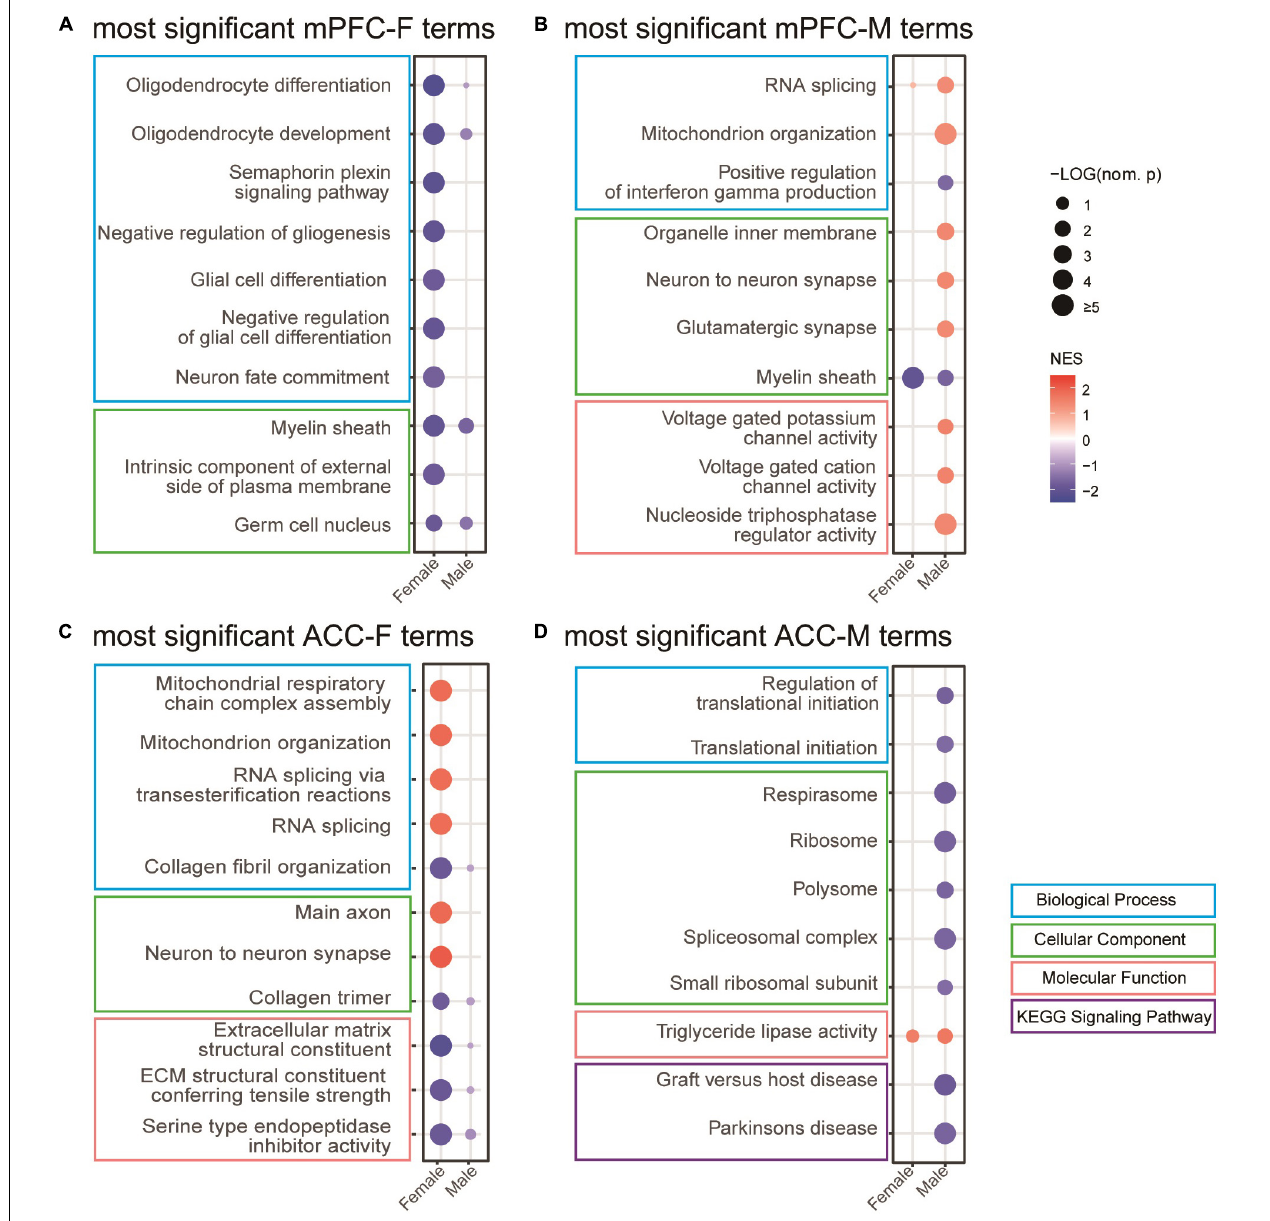
FIGURE 6 | Gene set enrichment analysis (GSEA) of the transcriptomic changes in the mPFC and the ACC of female and male mice at 2 weeks after SNI. Most significantly regulated gene sets in the mPFC of female (mPFC-F, A ) and male (mPFC-M, B ) mice, as well as in the ACC of female (ACC-F, C ) and male (ACC-M, D ) mice, comparing the sham versus SNI groups. The size of the dots indicates the –log 10 (nominal p ) values, and the color indicates the normalized enrichment scores